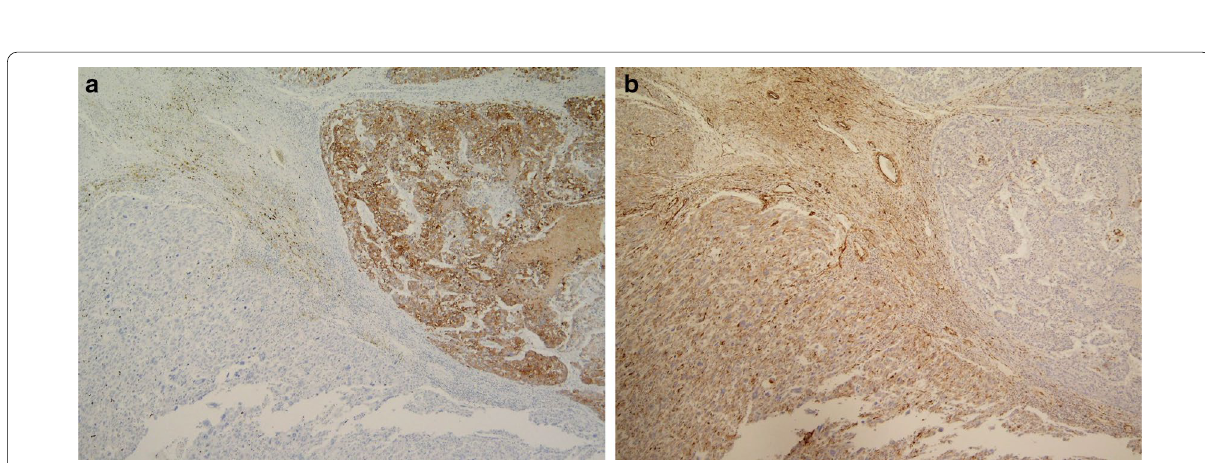
Fig. 6 Immunohistochemically, the carcinomatous component was positive for CK7 ( a ), CK20, EMA, CDX2, AFP, and partly positive for vimentin. On the other hand, the spindle‑shaped pleomorphic sarcomatous component was strongly positive for vimentin ( b